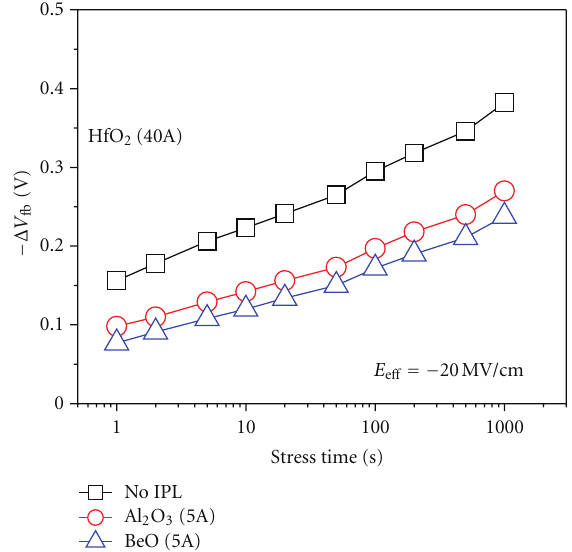
Figure 5: Stress-induced V fb shift ( Δ V fb ) versus stress time for three di ff erent gate stacks. E e ff = ( V g − V fb